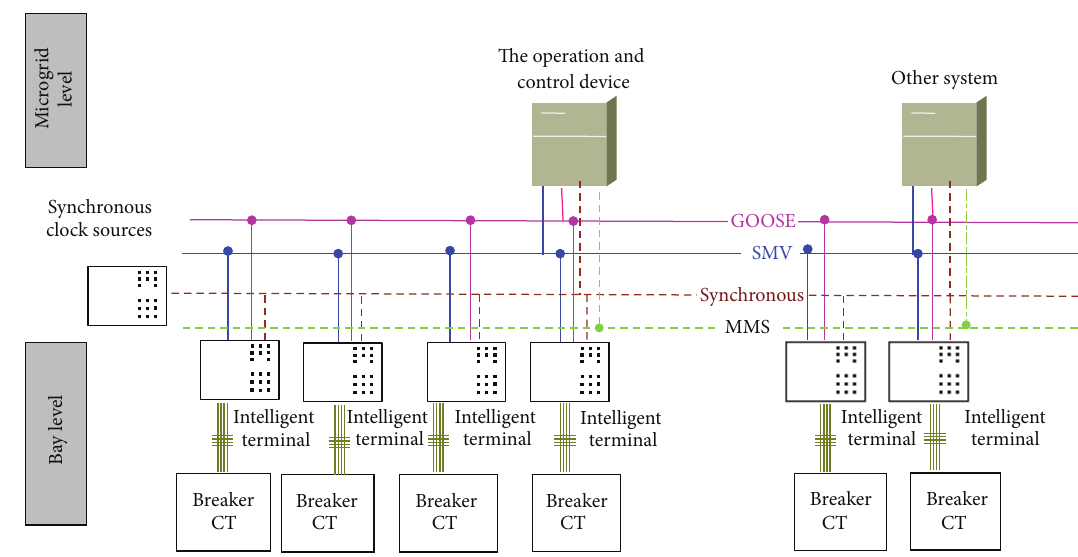
Figure 10: Communication architecture of the microgrid based on